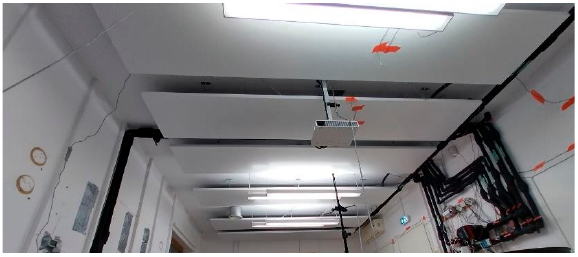
Figure 6 . Installation of the ceiling panels.